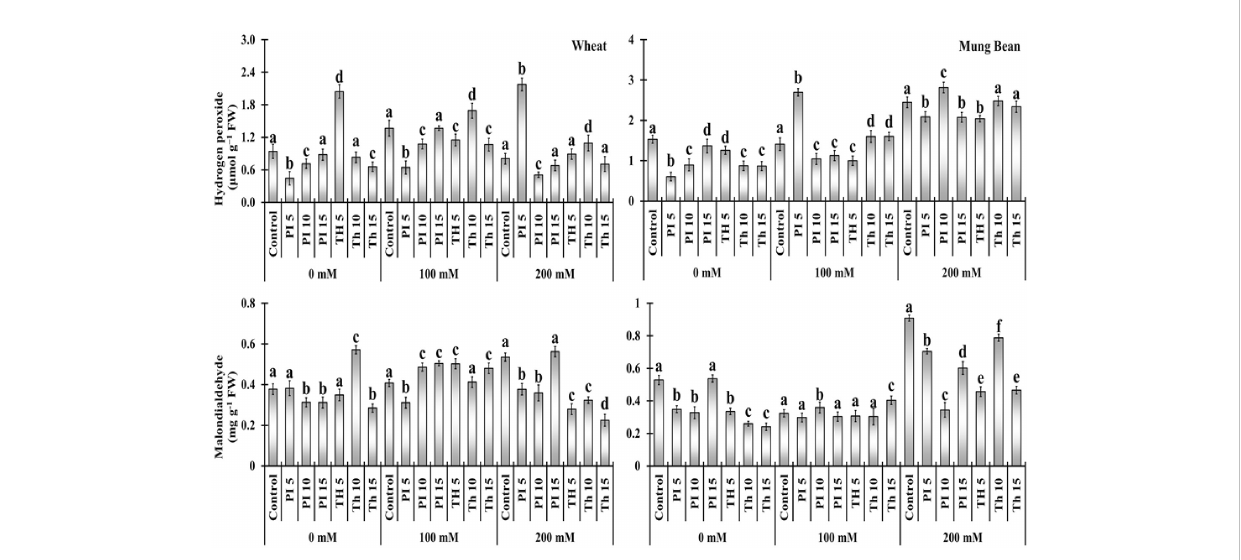
FIGURE 4 Effects of bio-priming with fungal endophytes on hydrogen peroxide (H 2 O 2 ) and Malondialdehyde (MDA) contents of wheat and mung bean grown under saline environment. The symbols on the horizontal axis represents: Control: Seeds without priming, Pl = Seed priming with Paecilomyces Trichoderma hamatum 5, 10, 15 = duration of bio-priming in minute, 0, 100 & 200 mM NaCl concentration. On lilacinus , Th = Seed priming with bars, vertical lines represent ± Mean Standard Error (S.E) and similar alphabets represents non-signi fi cant difference between the means of treatment at p<0.05